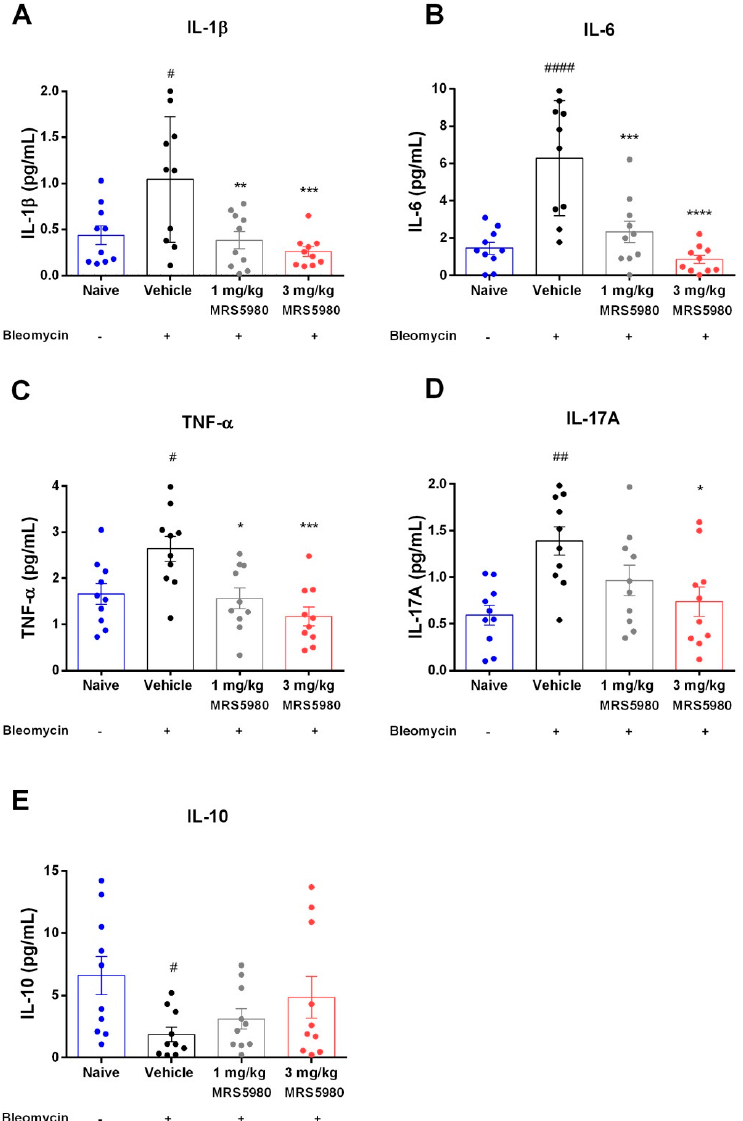
Figure 5. Determination of inflammatory markers. Analysis of IL-1 β ( A ), IL-6 ( B ), TNF- α ( C ), IL-17A content ( D ) and IL-10 ( E ) in plasma samples of different experimental groups. The values are expressed as pg/mL of plasma. Data are mean ± S.E.M., n = 10 animals per group. # p < 0.05, ## p < 0.01 and #### p < 0.0001 vs. naïve; * p < 0.05, ** p < 0.01, *** p < 0.001 and **** p < 0.0001 vs. vehicle.